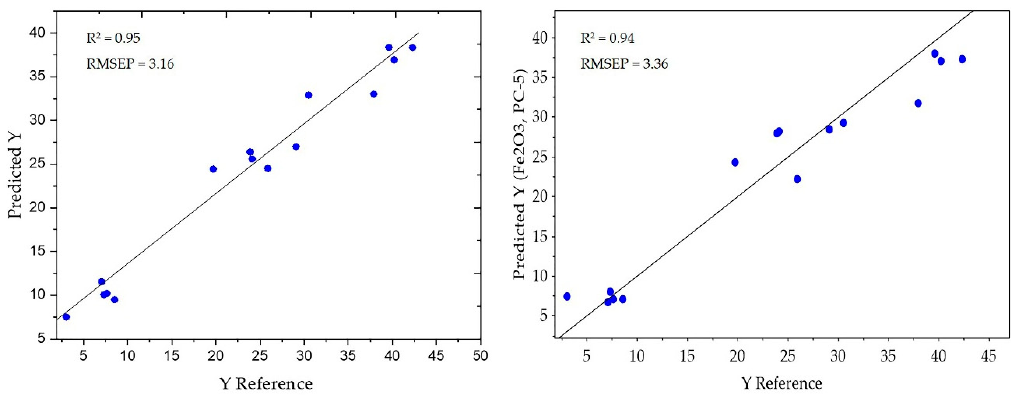
Figure 5. ( a ) SVR; and ( b ) PCR regression results for the predicted vs. actual Fe 2 O 3 concentration after applying low-level fusion on the normalised MWIR and LWIR data blocks.